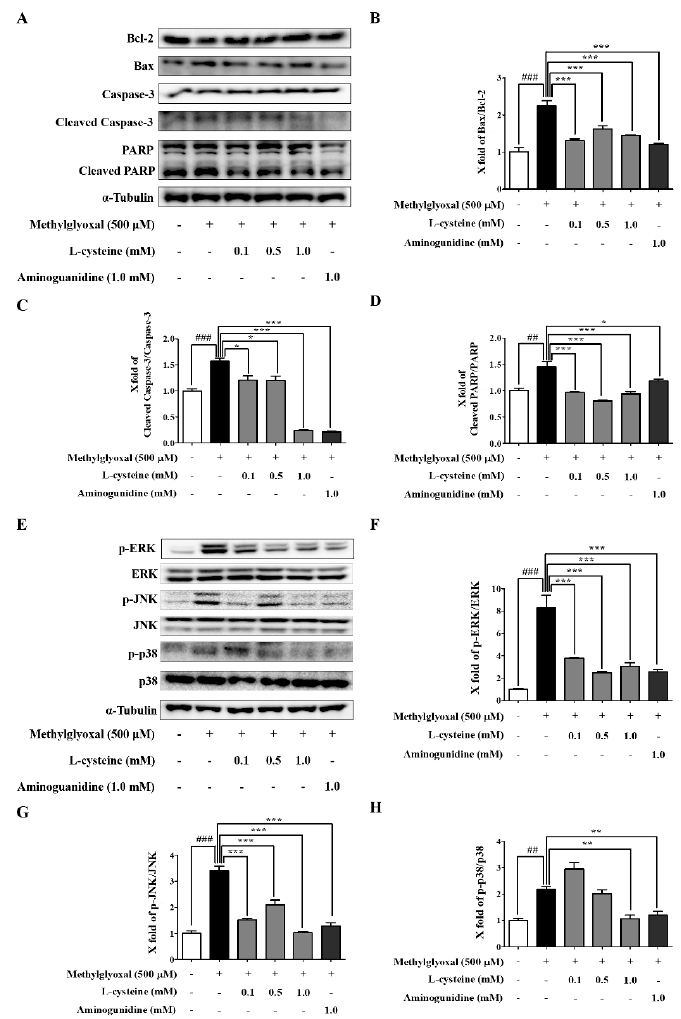
Figure 3. E ff ects of l -cysteine on apoptosis-related proteins and mitogen-activated protein kinase (MAPK) signaling pathway in MES13 cells. Cells were pretreated with l -cysteine for 1 h, followed by incubation with 500 µ M MGO for 24 h. ( A ) The protein expression levels of Bax, Bcl-2, Caspase-3, and PARP were measured using western blot. ( B – D ) Bax / Bcl-2 ratio, Caspase-3, and PARP band intensity; α -tubulin was used as an internal control. ( E ) MES13 cells were pretreated with l -cysteine for 1 h, then incubated with 500 µ M MGO for 1 h. The protein expression levels of MAPKs